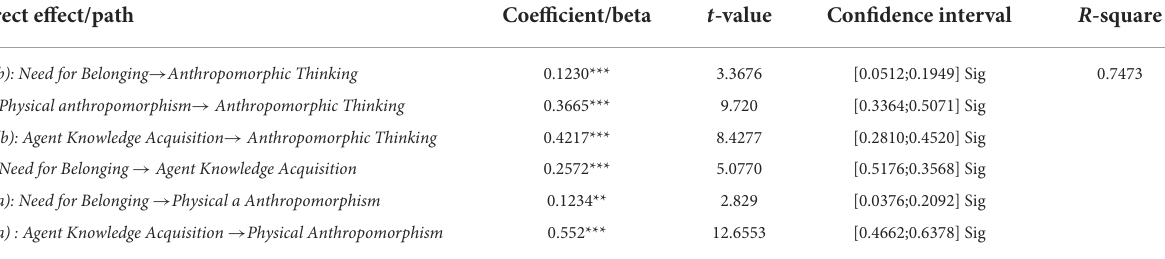
TABLE 5 Path (structural) coefficients and their significance at * p < 0.05, ** p < 0.01, *** p <